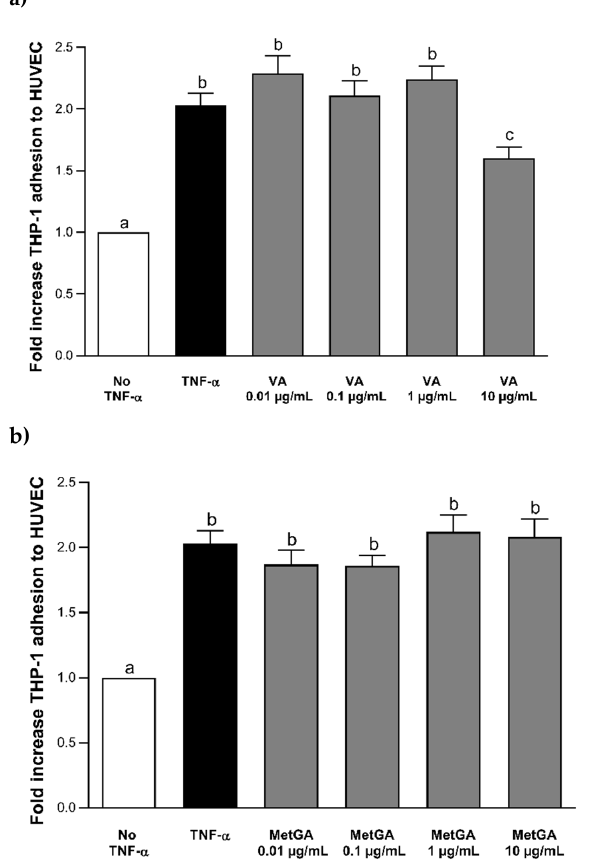
Figure 3. Effect of different concentrations (0.05–50 µM) of VA ( a ) and MetGA ( b ) on THP-1 adhesion to HUVECs. Results are expressed as mean ± standard error of mean. a,b,c Bar graphs reporting different letters are significantly different ( p ≤ 0.05).